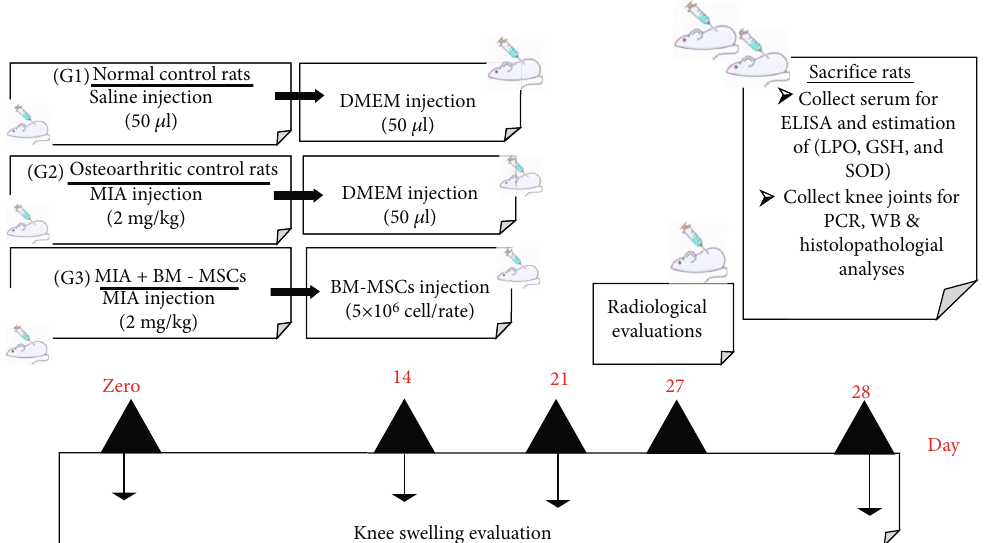
Figure 1: Timeline of the experiment depicting OA induction on zero day, treatment on the 14 th day, and sacri fi ce of animals on the 28 th